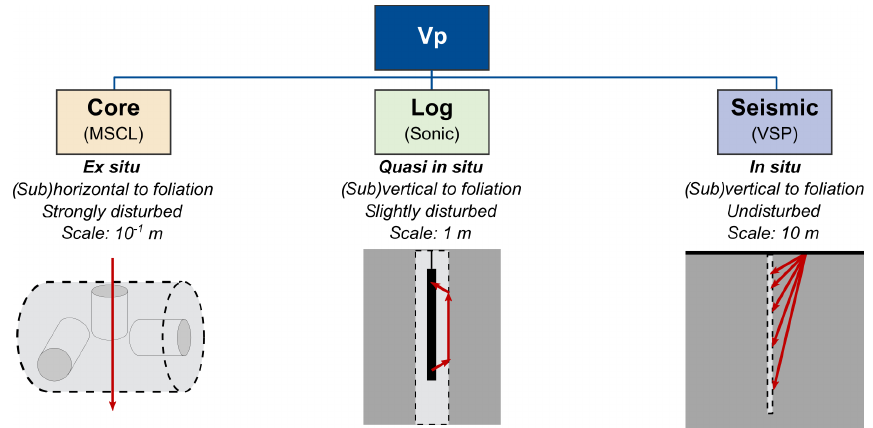
Figure 2. Schematic depicting the different environmental and measurement conditions of the core, log, and borehole seismic (VSP) P-wave velocity (Vp) measurement. Arrows indicate the direction of seismic wave